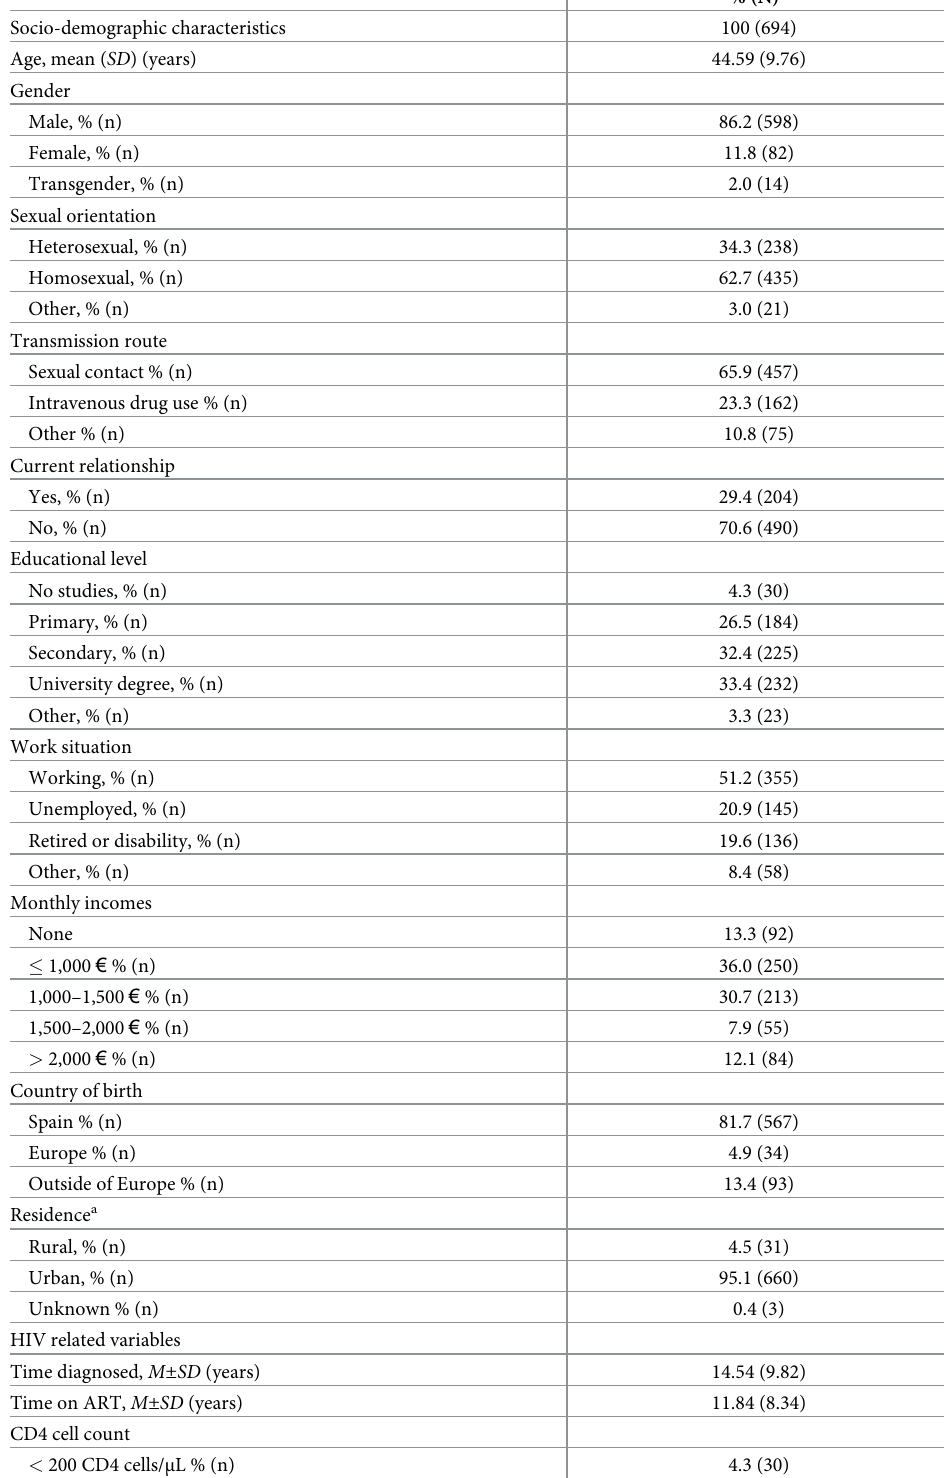
Table 1. Participants’ socio-demographic and HIV-related